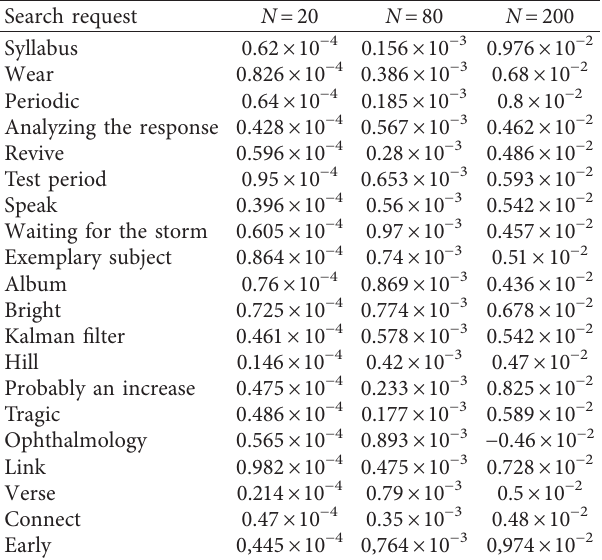
Table 6: Time of ranking operation ( s ) depending on the sample size in the parallel implementation of the